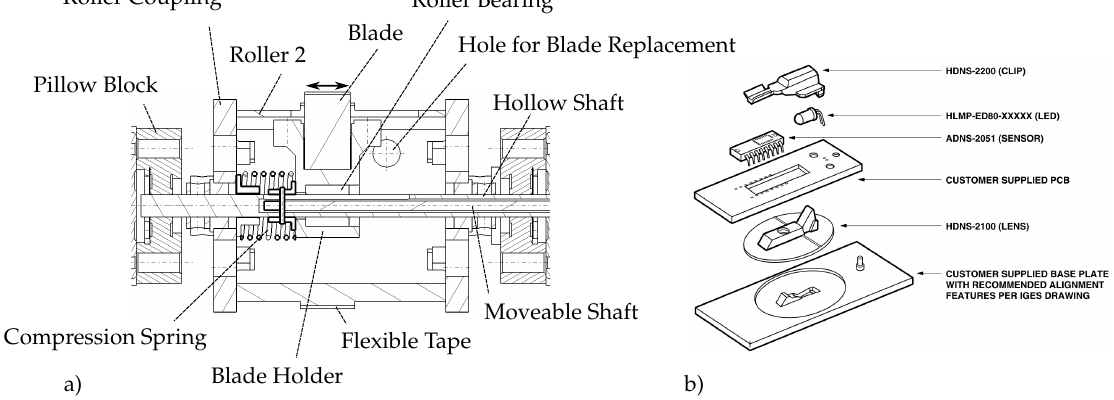
Figure 6. Schematic principle of the adaptive feeding roller and the optical sensor